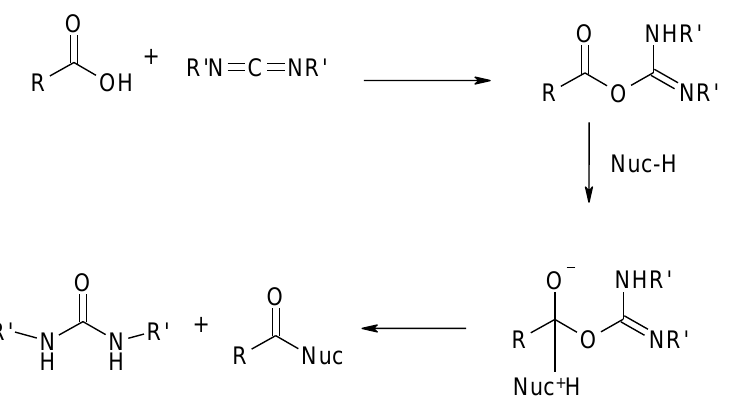
Figure 15. Activation of the carboxyl group using carbodiimide derivatives and subsequent reaction with nucleophilic reagents.